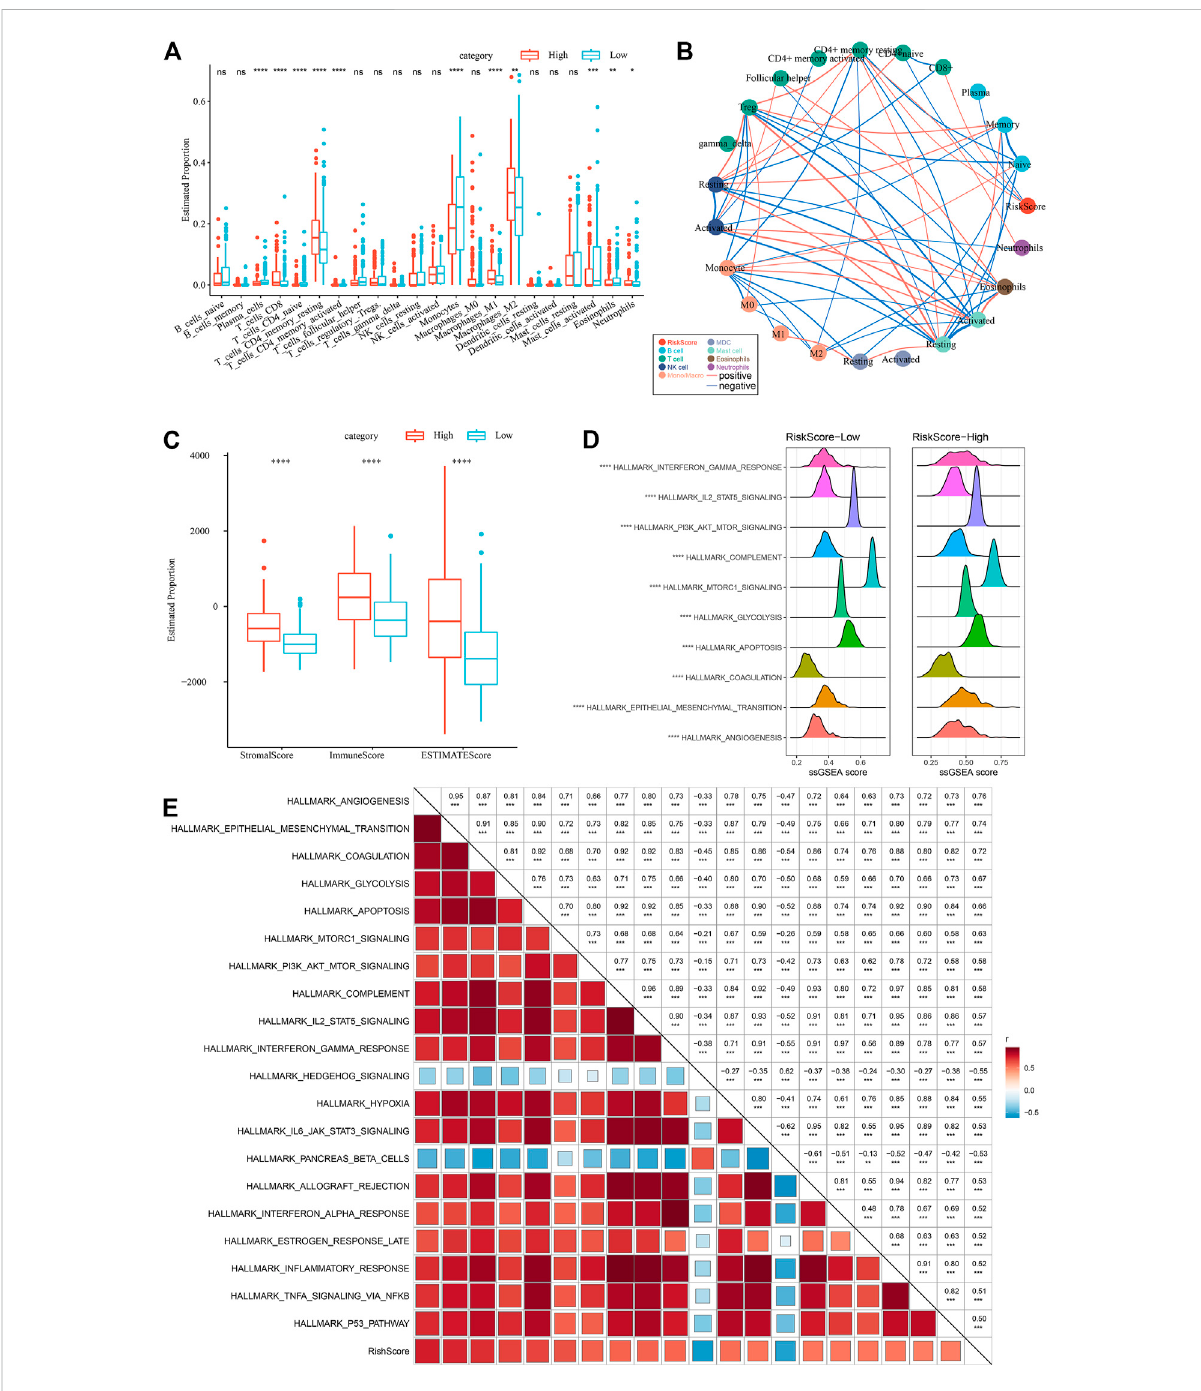
FIGURE 11 Different immune cells with different in fi ltration levels in the RiskScore grouping. (A) Proportion of immune cell components in the TCGA cohort. (B) Correlationanalysisbetween22immunecellcomponentsandRiskScoreintheTCGAcohort. (C) Proportionofimmunecellcomponents calculated by ESTIMATE software in the TCGA cohort. (D) Top10 pathways with the most major variations between RiskScore-High and RiskScore- Low. (E) Results of correlation analysis between KEGG pathways with RiskScore correlations greater than 0.5 and